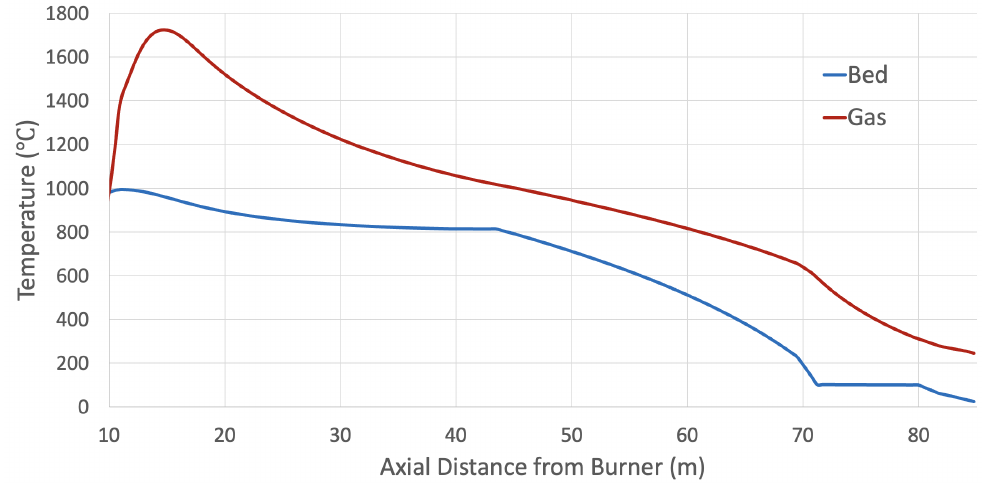
Figure 6. Simulated bed and average axial gas temperatures for a wet